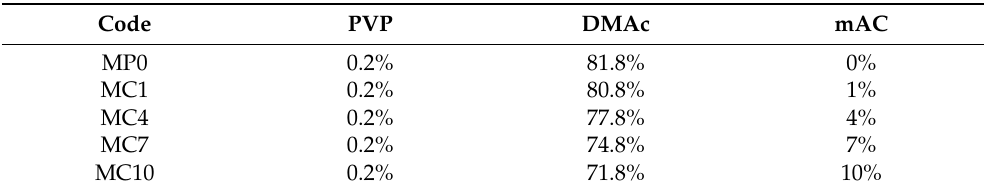
Table 1. Membrane fabrication using 18% ( w/w ) of PES, PVP and by varying DMAc solvent, modified activated